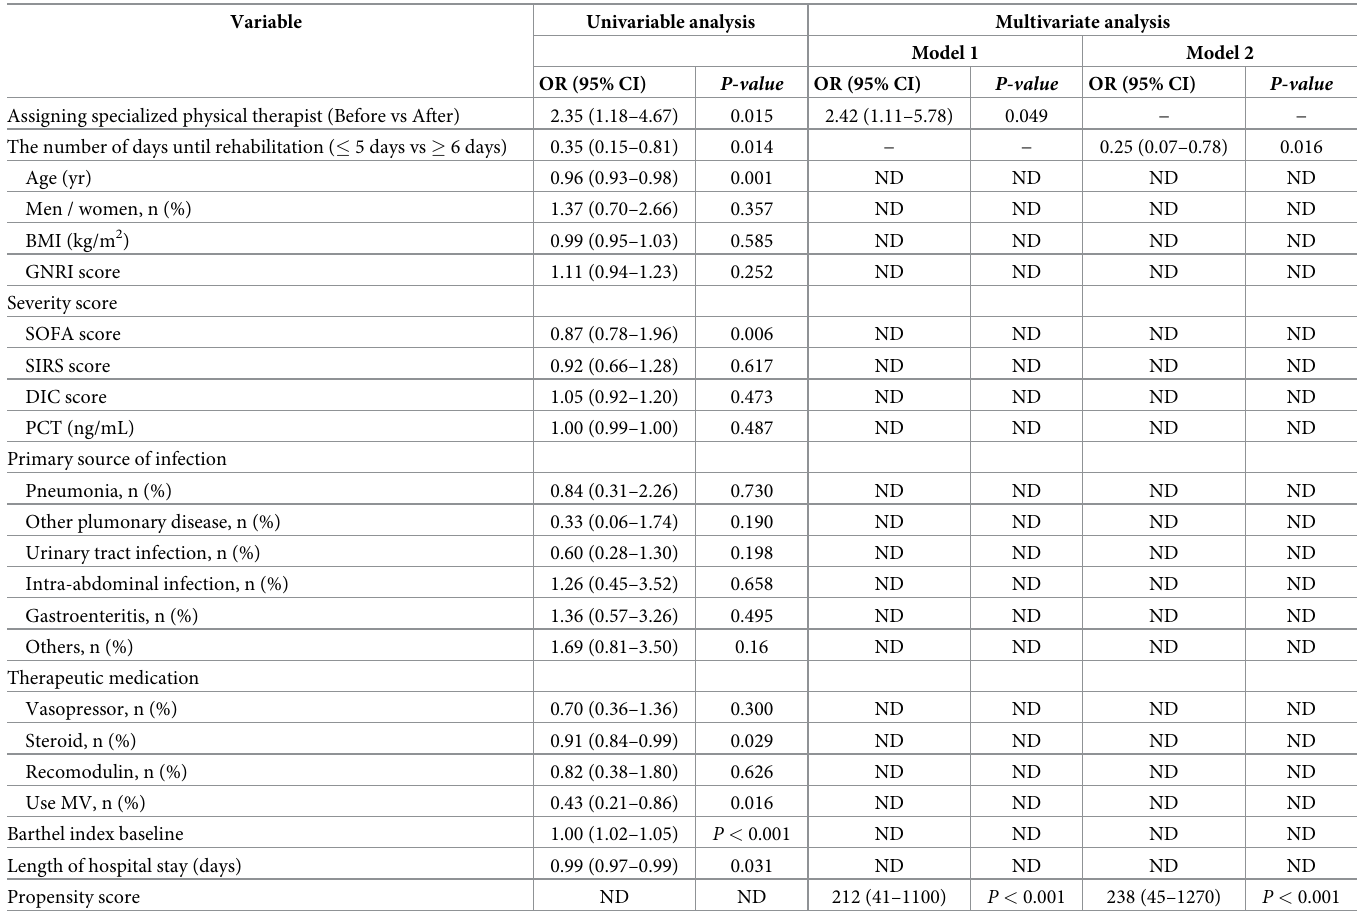
Table 2. Logistic regression analysis of return to independent ADL at hospital